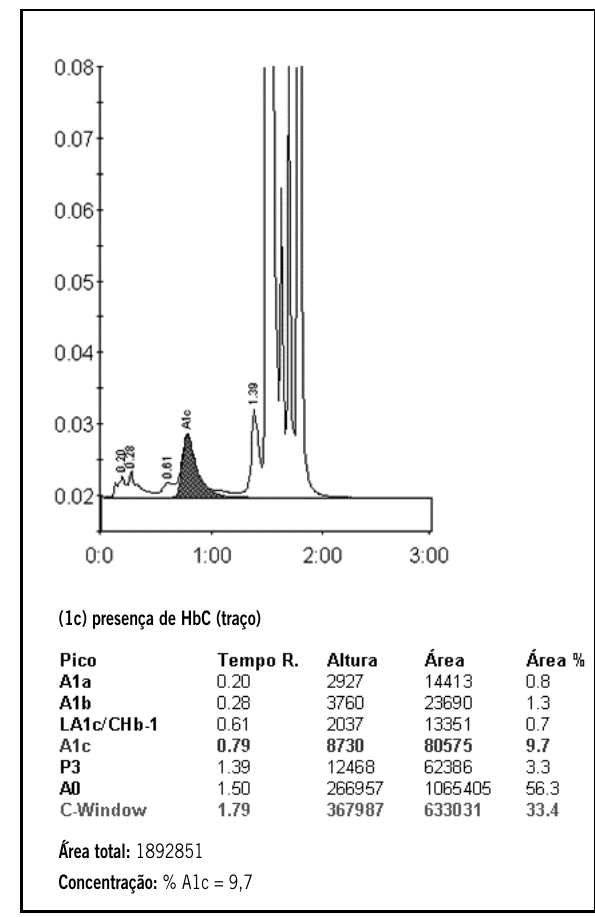
Figura 1b – Cromatograma de hemoglobinas glicadas e parâmetros de análise por CLAE, equipamento D10, Bio Rad; (b) presença de Hb fetal. Pico de A1C mostrado